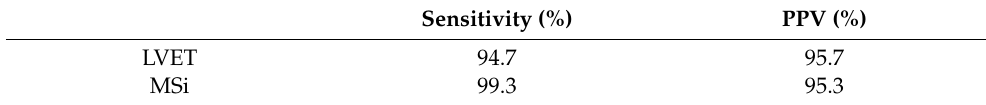
Table 1. Sensitivity and PPV of respiratory acts detection in the LVET and MSi trends.